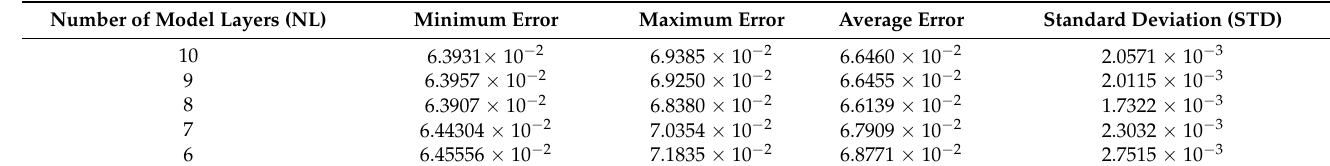
Table 5. Statistical analysis of the error for optimization of the initial drug concentration (Case 3).